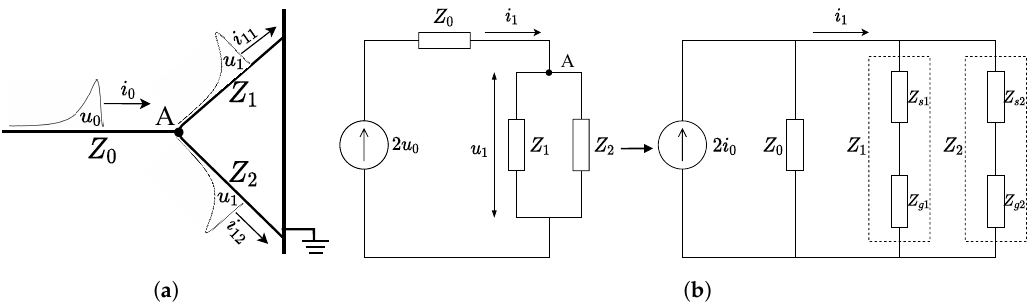
Figure 3. EM wave propagation process and the equivalent circuit for TEV detection. ( a ) EM wave propagation process. ( b ) Equivalent circuit of the TEV